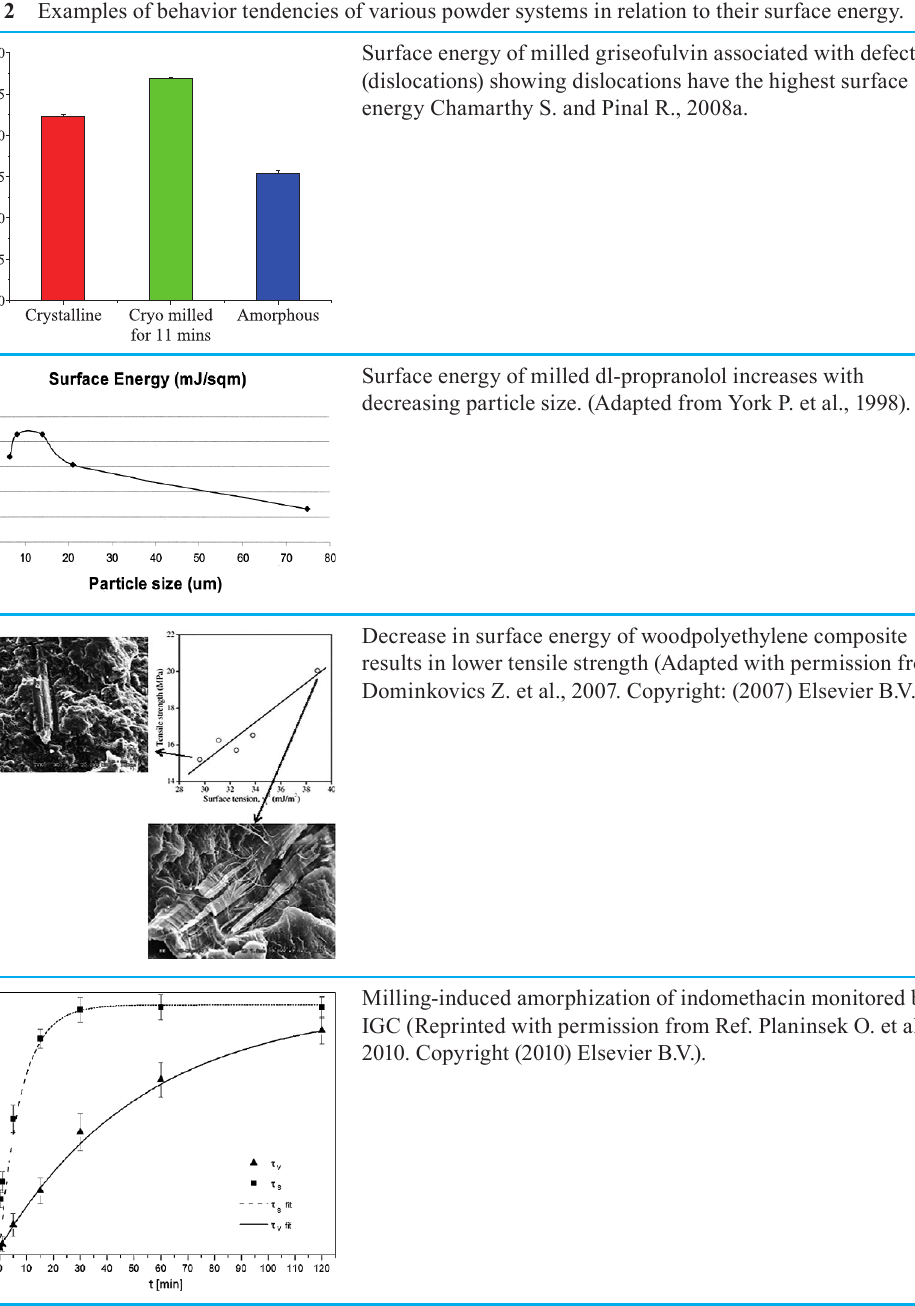
Table 4 . It is noteworthy that even though the starting material for making all five food powders is the same, the surface abundance of different chemical bonds, including the carbon/oxygen ratio, vary substantially among them.